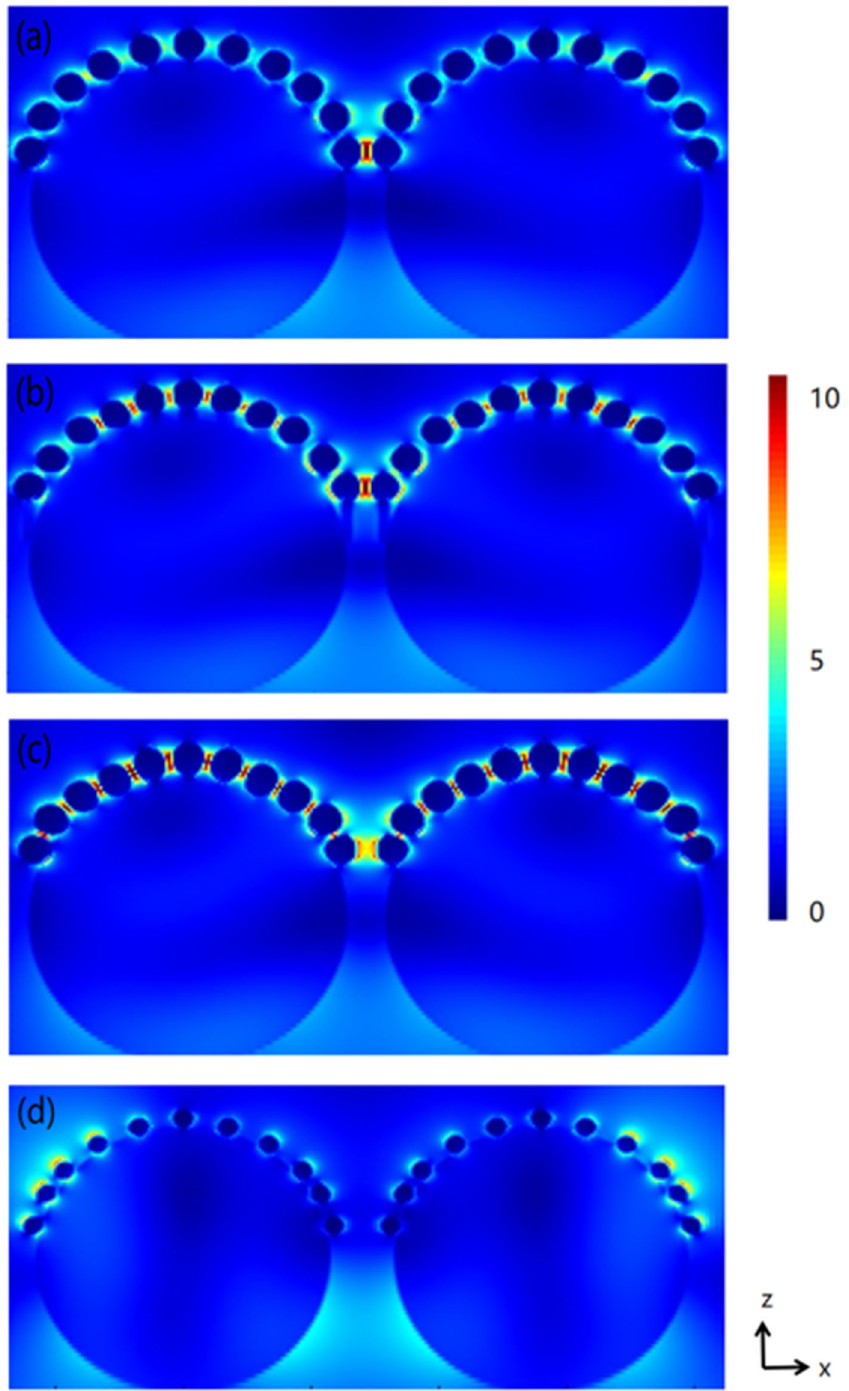
Figure 5. FDTD simulations of the electromagnetic field distribution and hot spots for different etching times ( a ) 0 s, ( b ) 30 s, ( c ) 60 s, ( d ) 90 s. To analyze enhancement factor (EF), the 4 ‐ MBA signals of the presence and absence of SERS substrates are compared. The formula is used to analyze enhancement factor, EF = (I SERS /N SERS )/(I NR /N NR ). I SERS and I NR are the SERS intensity detected on SERS substrate and the Raman characteristic peak intensity of pure 4 ‐ MBA powder, respectively. N SERS is the amount of 4 ‐ MBA adsorbed on SERS substrate and N NR is the amount of 4 ‐ MBA irradiated by laser spot. In the experiment, N SERS = N d A laser A N / σ , where σ is the area occupied by a probe molecule (0.33 nm 2 ), N d is the number density of colloidal spheres and A N is the